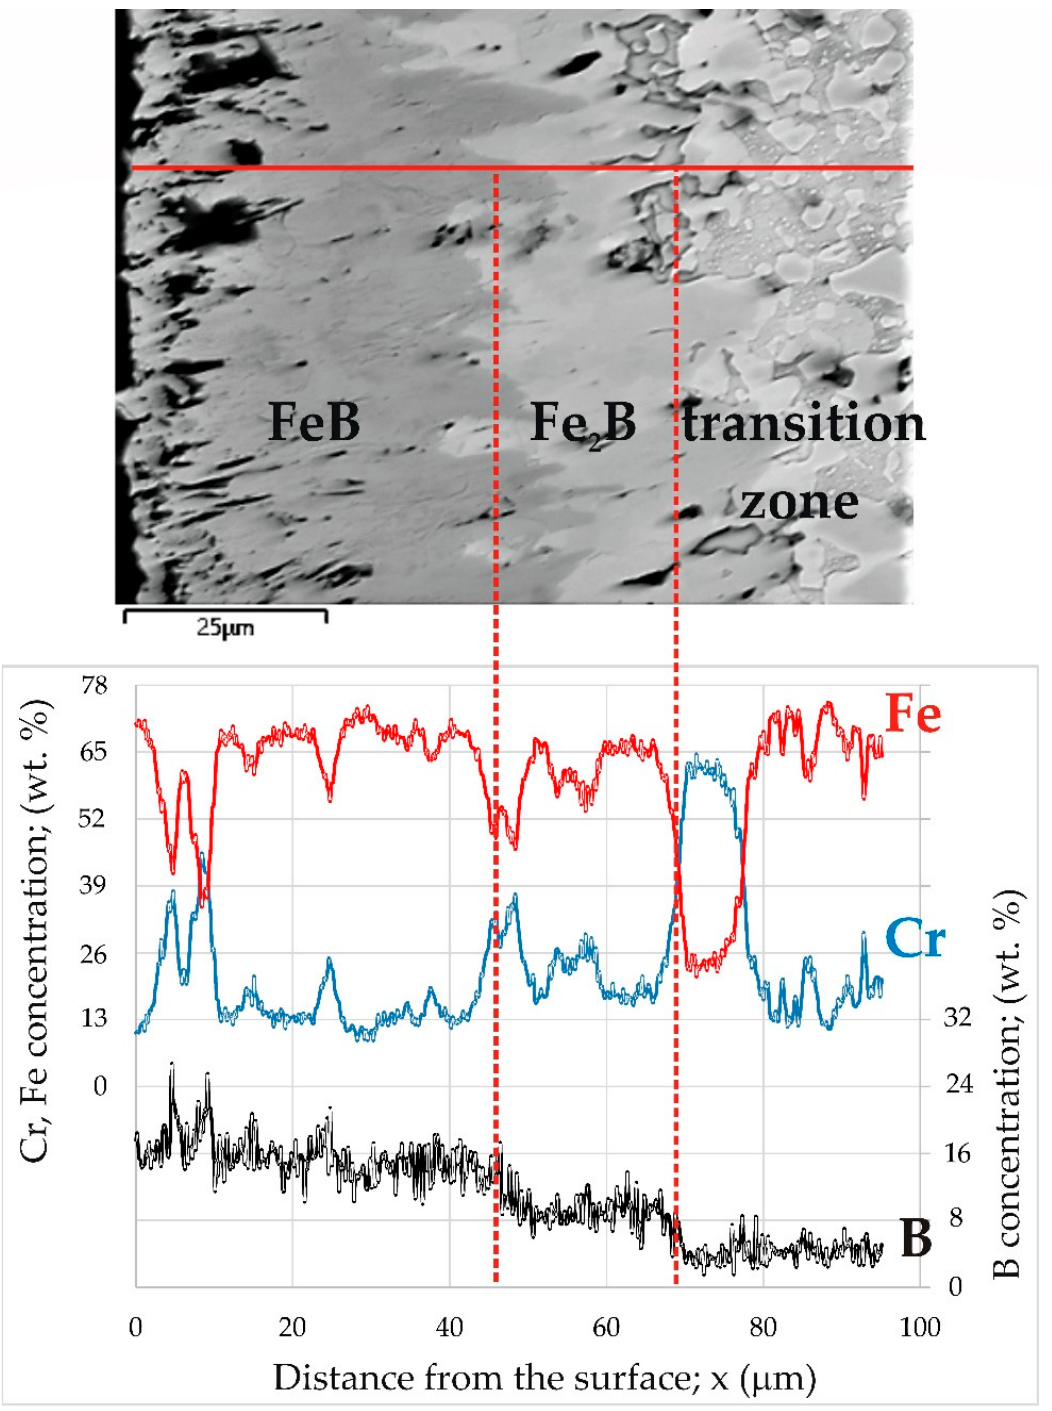
Figure 8. BSE image and results of line X-ray microanalysis performed for X165CrV12 tool steel after powder-pack boriding at the temperature of 1223 K for 9